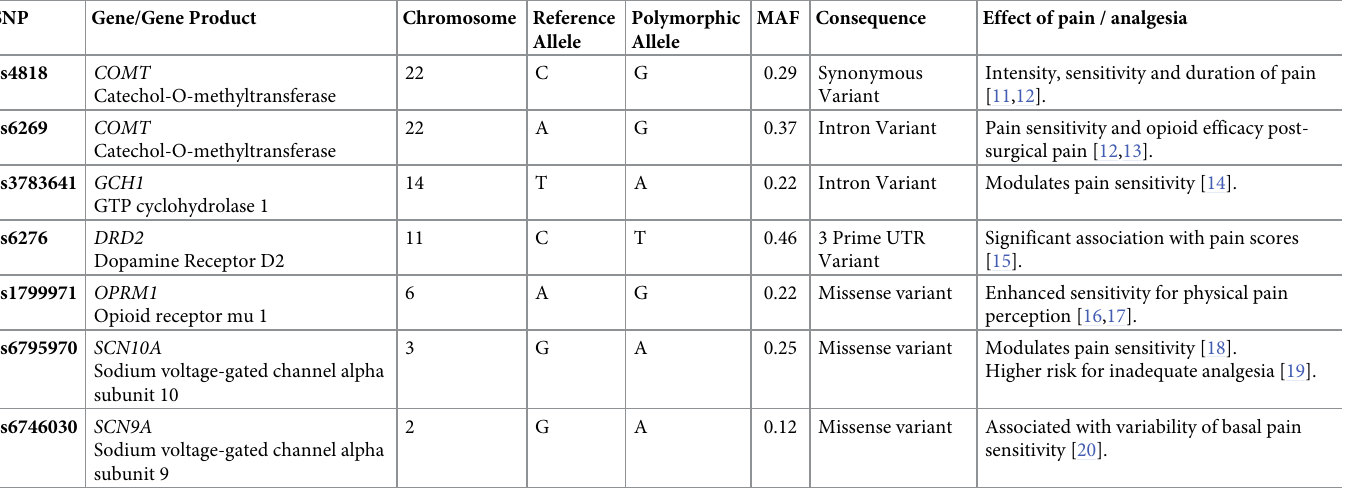
Table 2. Characteristics of the selected